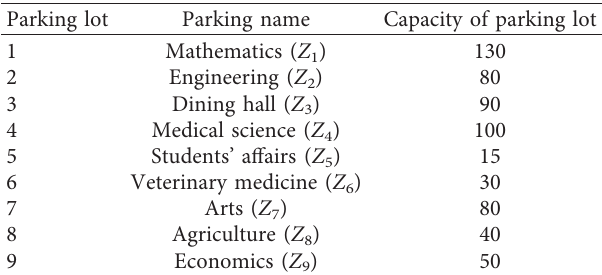
Figure 3: Parking lots in SBUK. Table 5: Classification of staff ( j